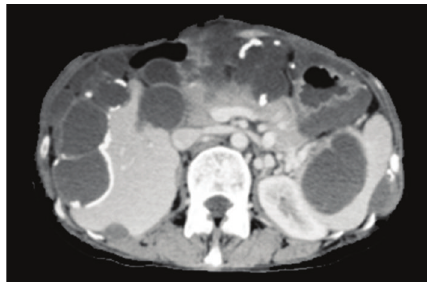
Figure 8: Axial contrast-enhanced CT scan of the upper abdomen demonstrates multiple low attenuated cystic lesions with rim-like calcifications scalloping the liver margin, infiltrating the spleen, and compressing the bowel, pancreas, and left kidney.